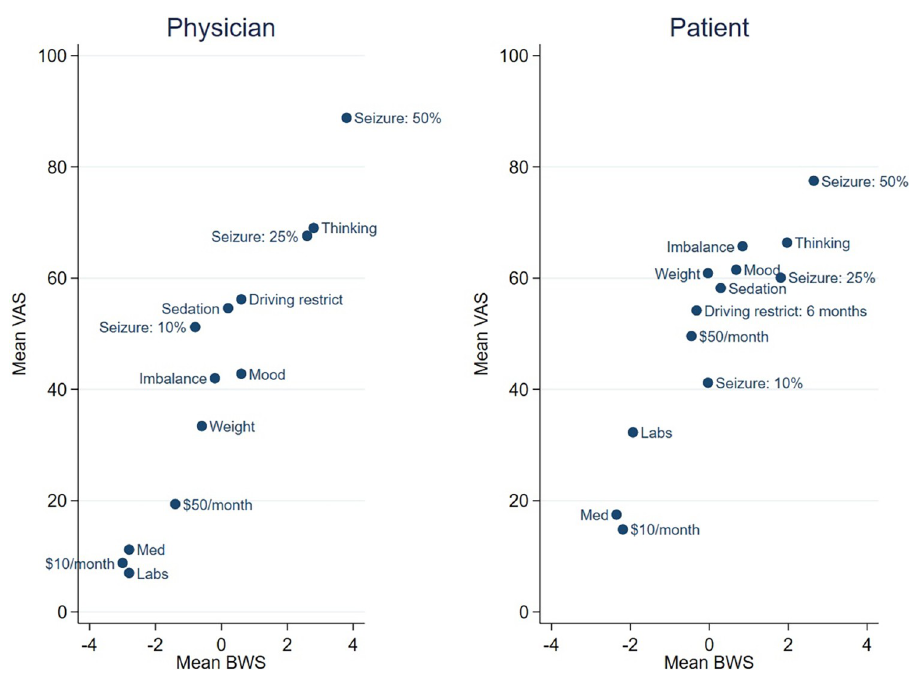
Fig 2. Correlation between mean VAS and BWS scores. Left: Physician responses (N = 5). Right: Patient responses (N = 31).